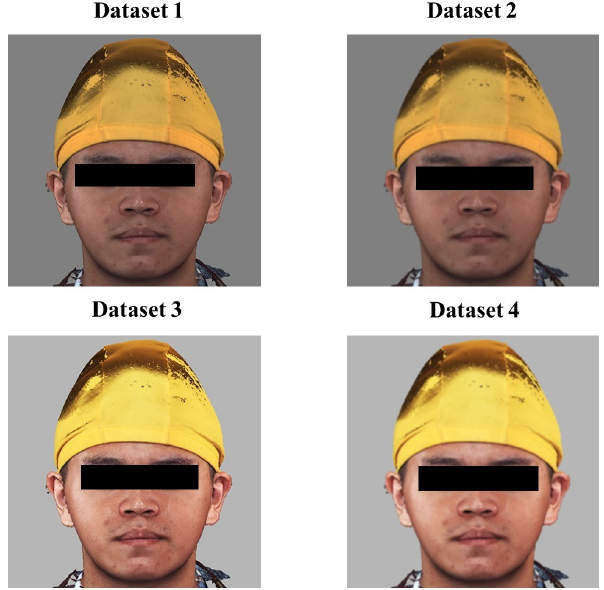
Figure 5. Schematic diagram of the four datasets.